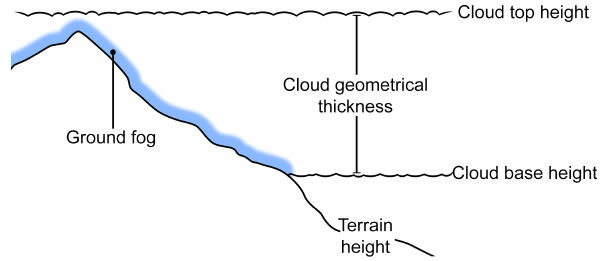
Figure 1. Ground fog detection under the assumption of a plane- parallel cloud geometry.